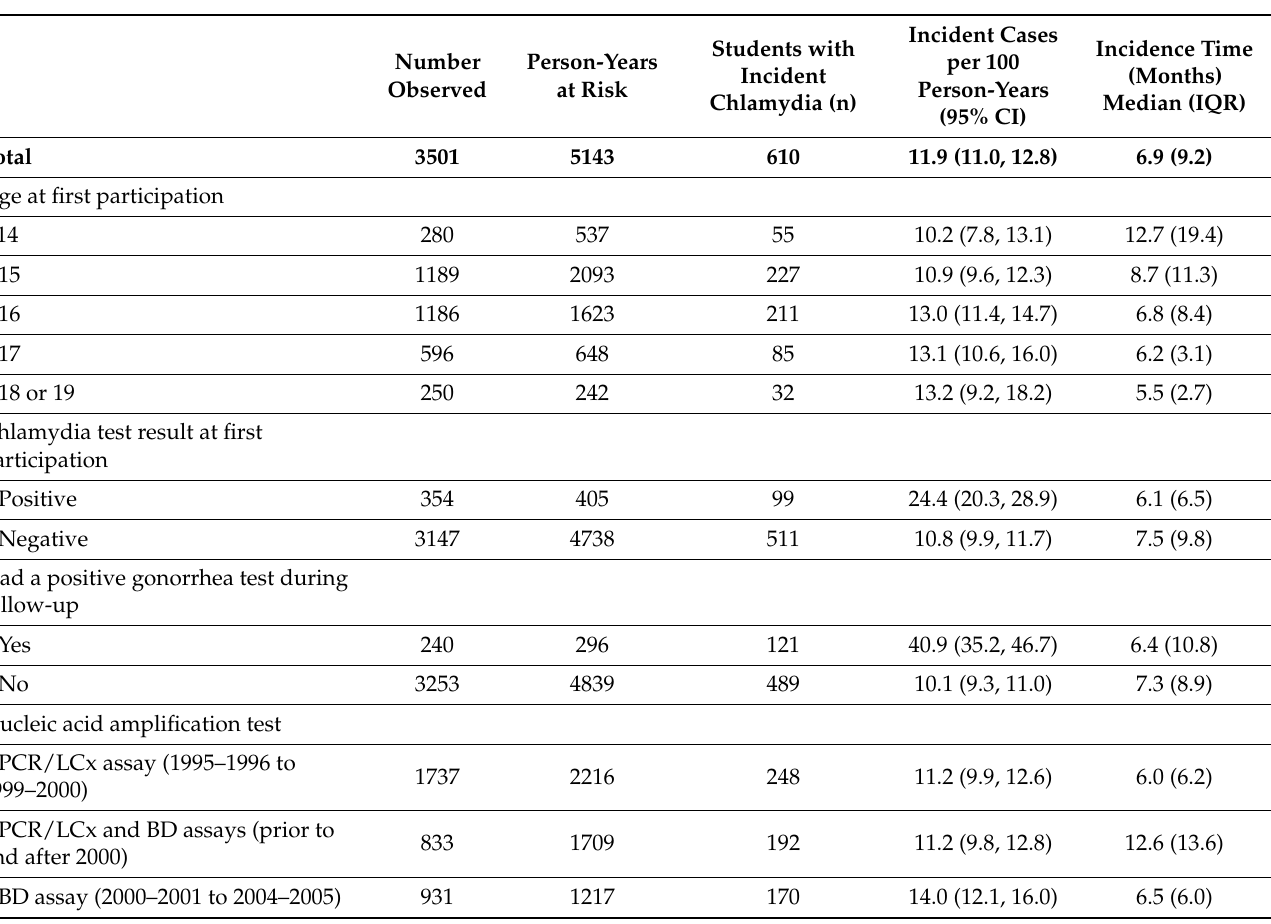
Table 2. Number of female students observed (n = 3501), person-times at risk, number of students with incident chlamydia, incidence rates, and incidence time among students who acquired incident infection (n =